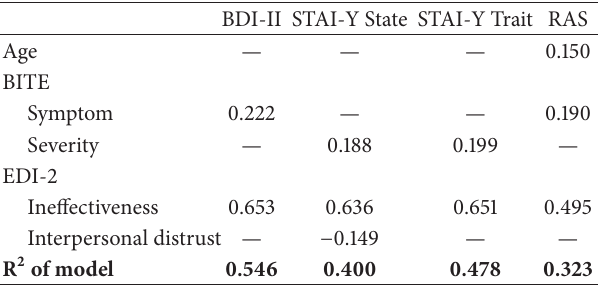
Table 3: Multivariate analysis of the associations between eating behaviours and psychological